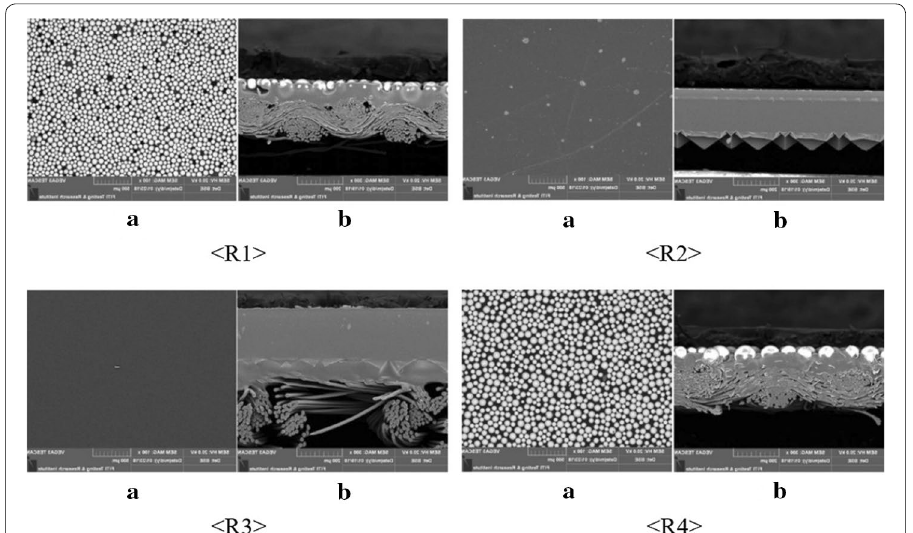
Fig. 2 Morphologies of SEM photos of surface ( a ) and cross-section ( b ) for each